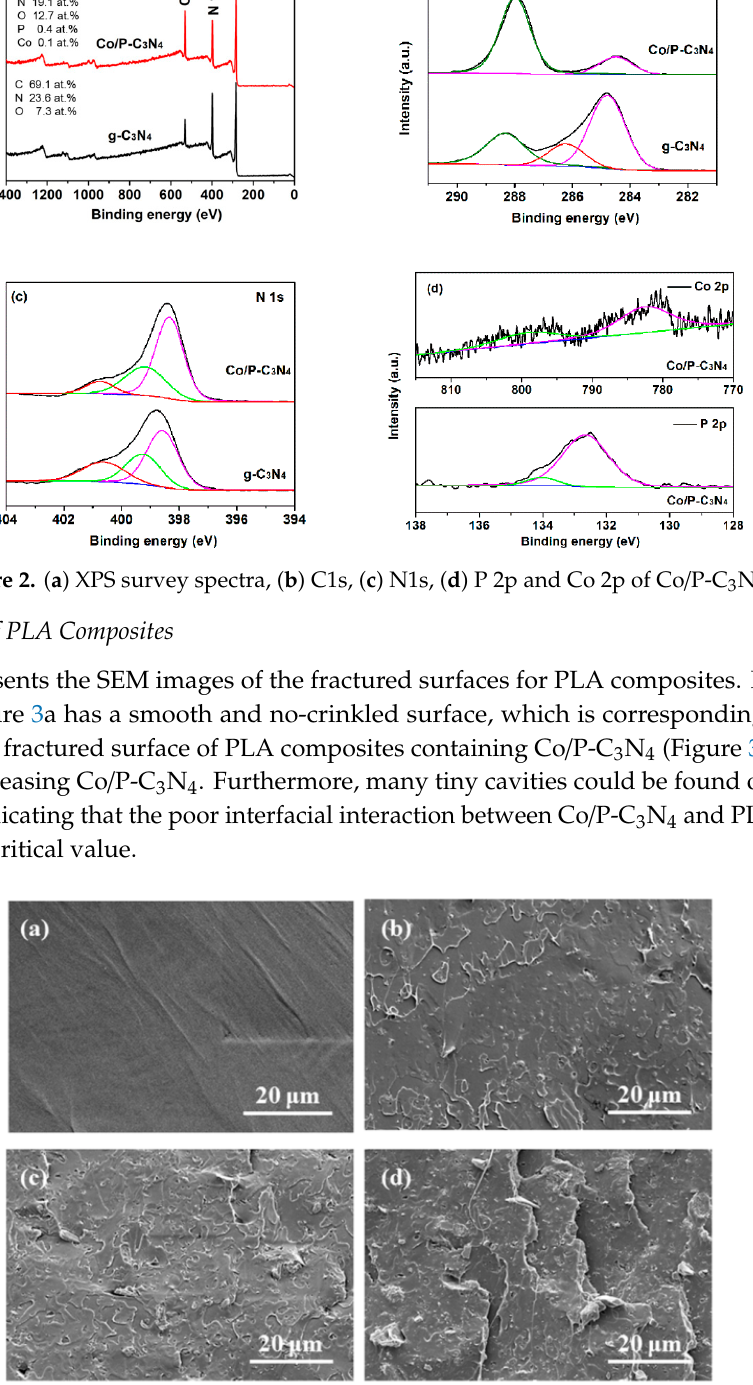
Figure 3. SEM images of pure PLA and PLA composites. ( a ) pure PLA, ( b ) Co/P-C 3 N 4 -2%, ( c ) ( c ) Co / P-C 3 N 4 -5%, and ( d ) Co / P-C 3 N 4 Co/P-C 3 N 4 -5%, and ( d ) Co/P-C 3 N 4 -10%.